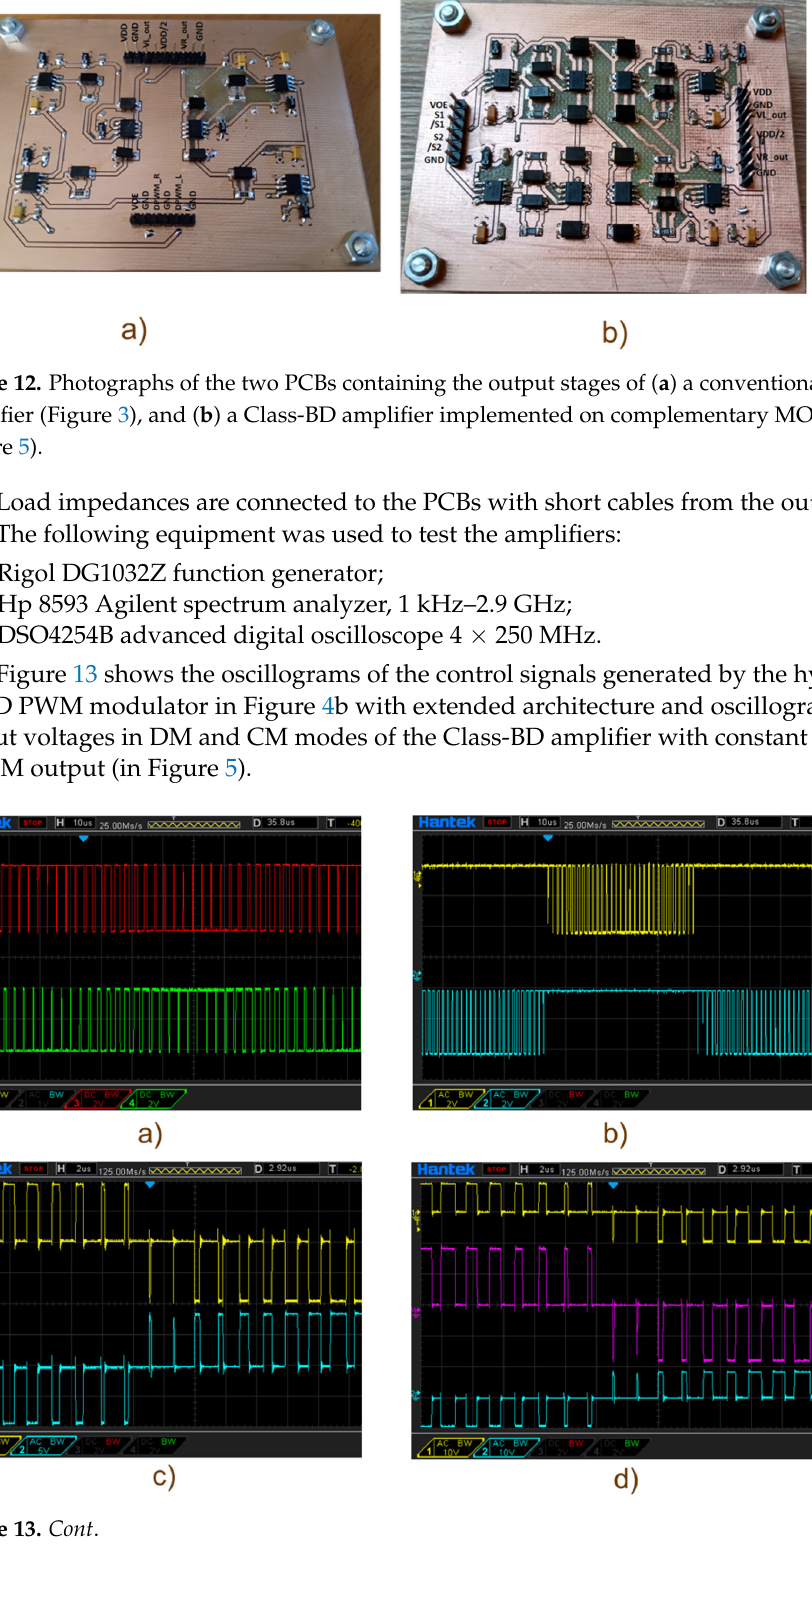
Figure 11. SPICE simulations of the low-power Class-BD amplifier with constant voltage at the CM output (in Figure 4a): ( a ) load current and output voltages in DM and CM modes; ( b ) output power and efficiency versus modulation index M.